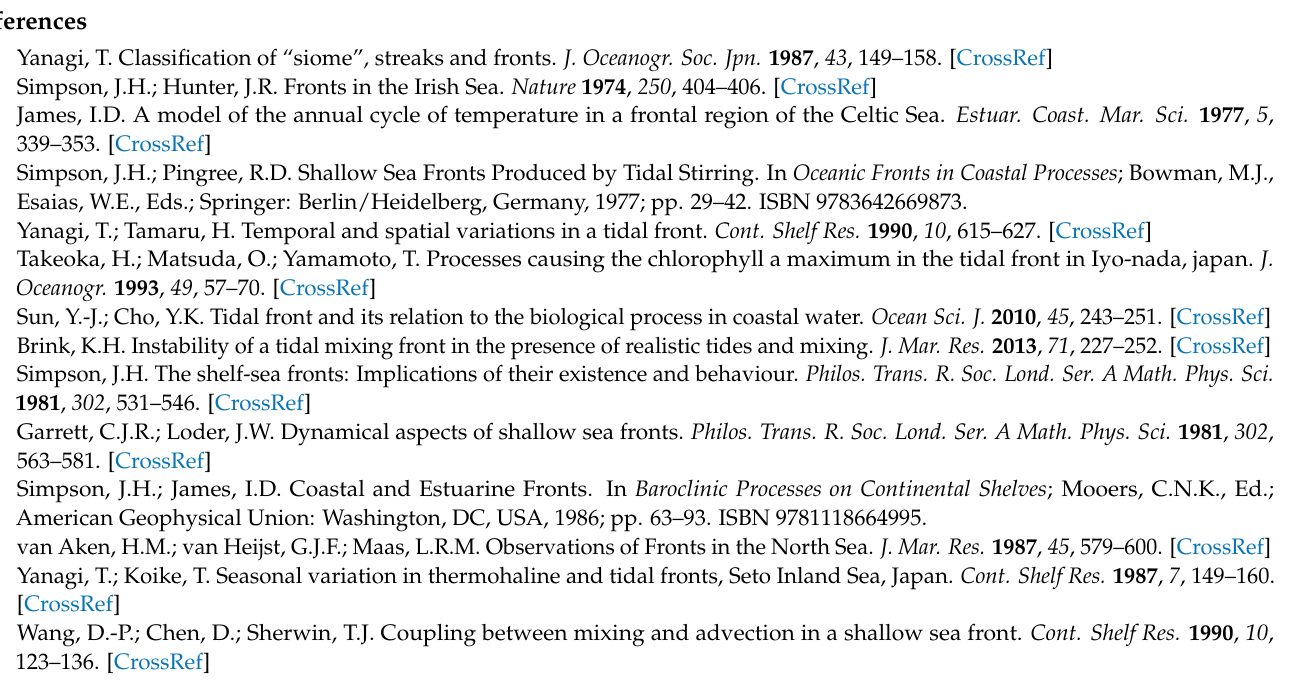
Figure A2. Spatial-temporal variations of ( a ) the front position ( D f , distance from the center point of the strait to the thick gray line in Figure 4) and ( b ) the front intensity ( T Gf , magnitude of the SST gradient on the thick gray line in Figure 4). The ordinate is angle for 46 rays starting from the strait (Figure 1d).